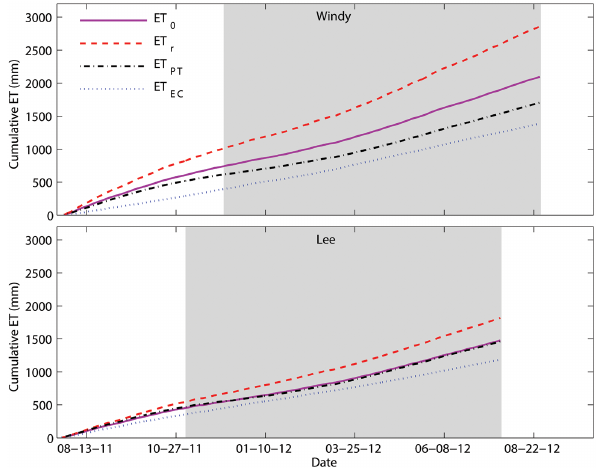
Figure 4. Daily measured and reference ETs for EC tower fields from the tower’s establishment until the end of the study period for each field.